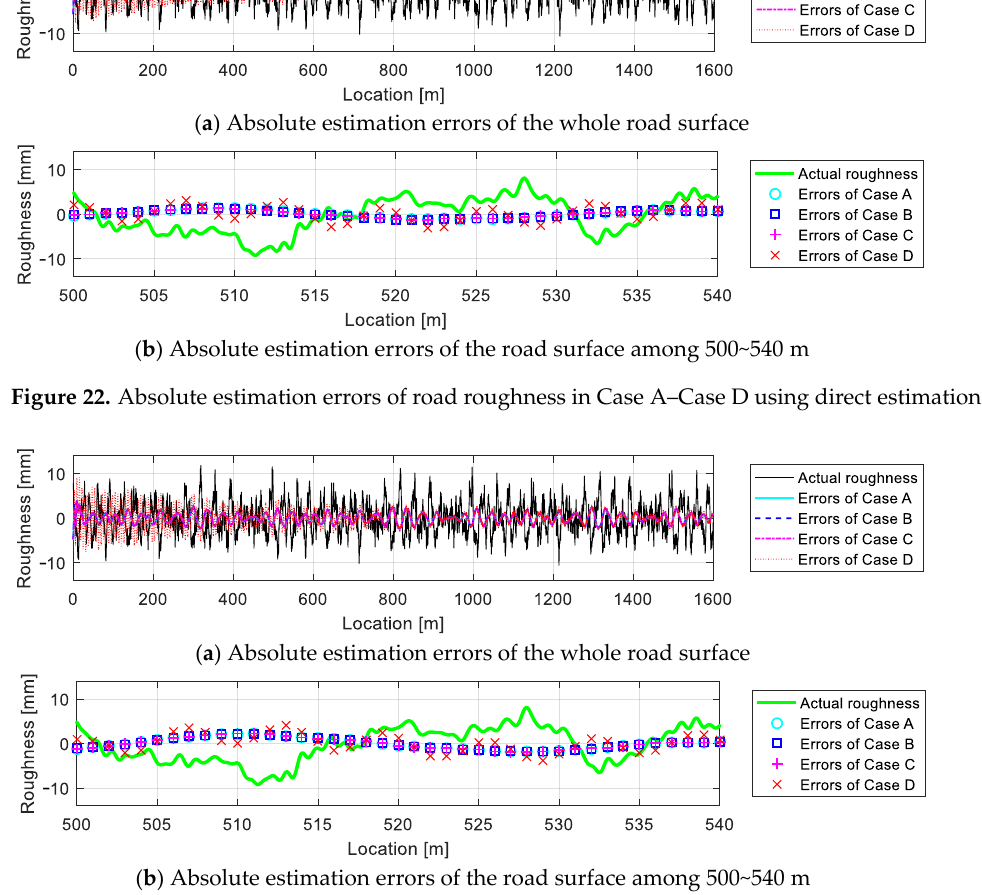
Figure 23. Absolute errors of road roughness in Case A – Case D using the updated FRF.